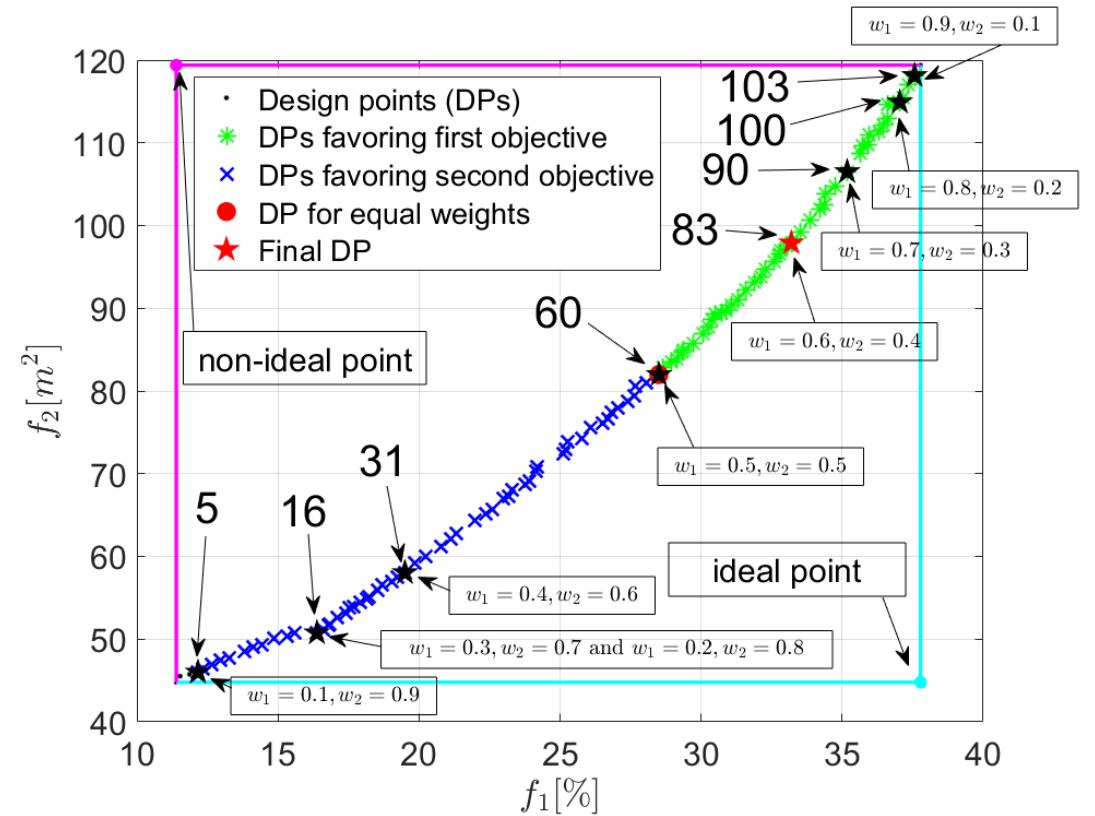
Figure 9. Pareto front with marked design points. Table 2. Results of decision-making procedure.